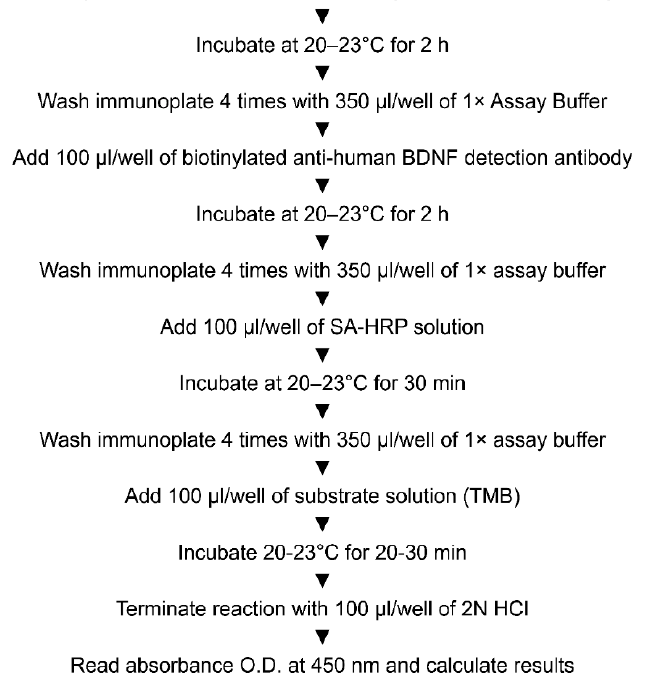
Figure 2. Summary of assay protocol. BDNF, brain-derived neurotrophic factor.